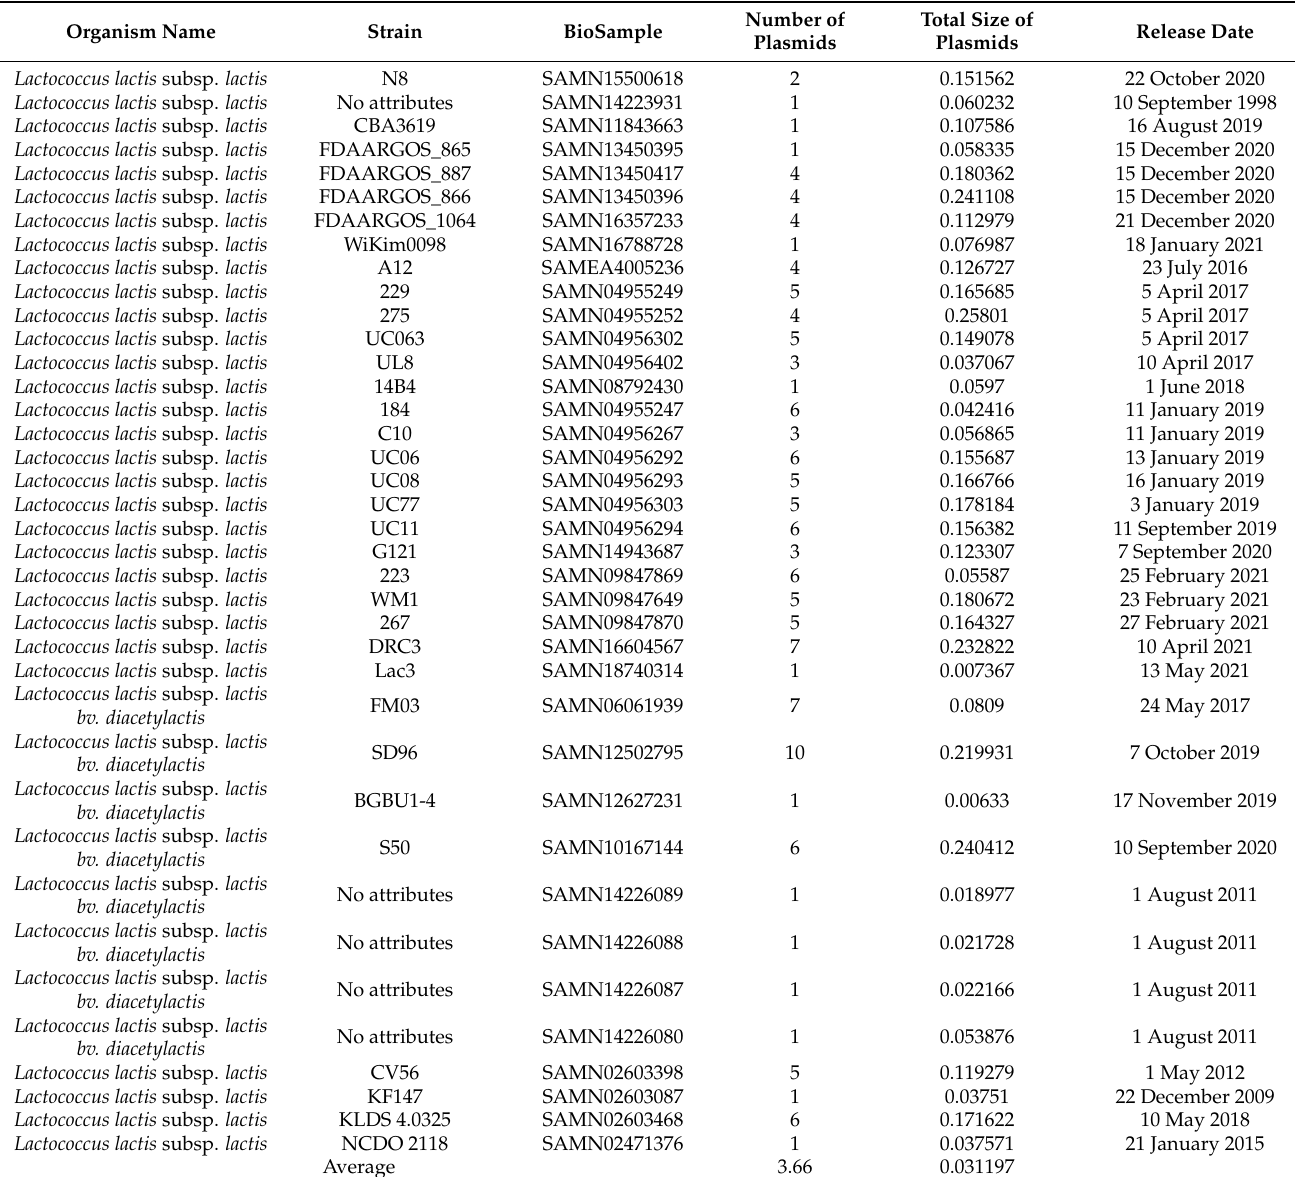
Table 3. Horizontal comparison of all L. lactis